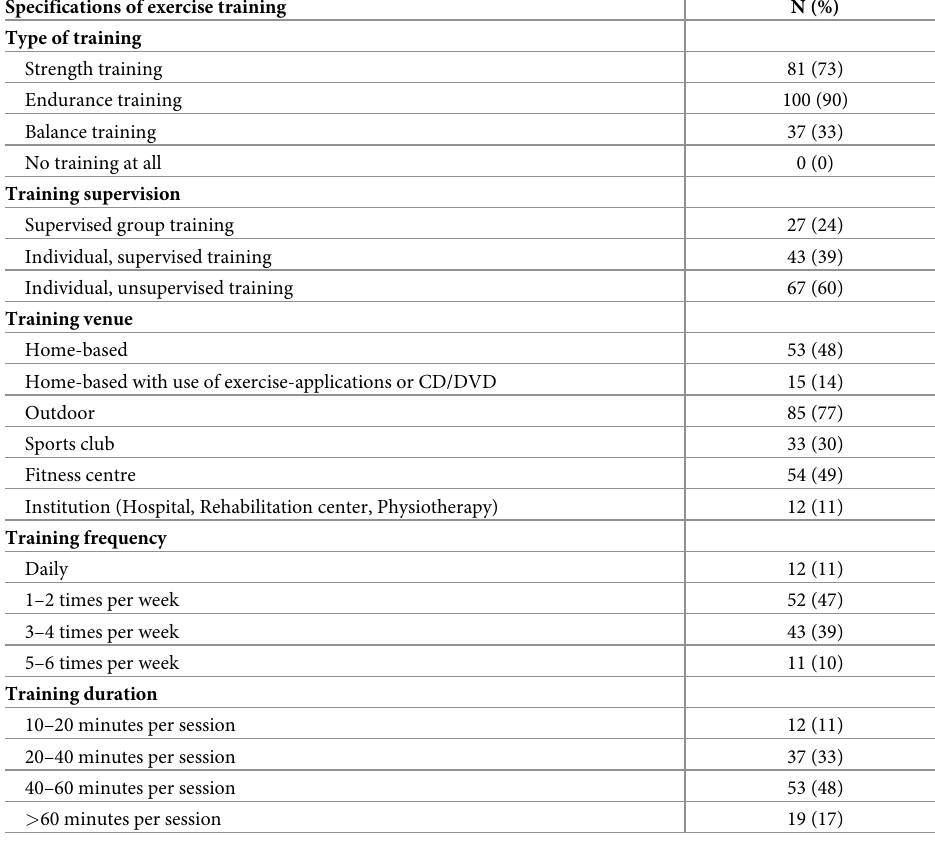
Table 4. Participants’ responses regarding the optimal exercise training program to improve their physical fitness (n =